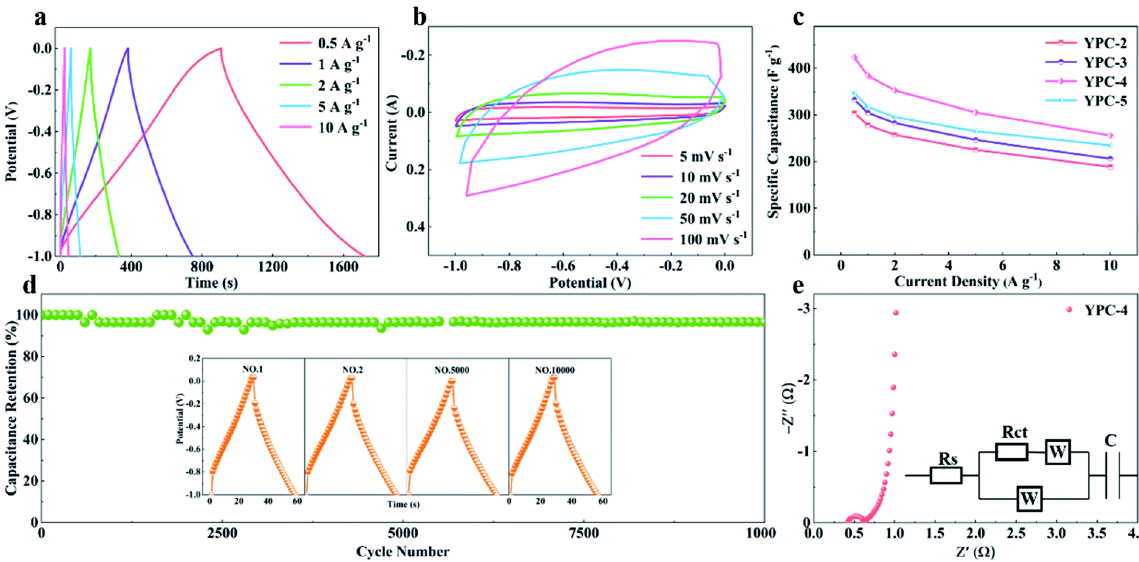
Figure 13. Electrochemical performance of YPC-4. ( a ) GCD profiles at different current densities; ( b ) CV curves at different scan rates; and ( c ) specific capacitance values of YPC-4 at different current densities. ( d ) Cycling performance of the YPC-4 electrode over 10,000 cycles at 10 A g − 1 ; the inset shows the GCD profiles at different cycles. ( e ) Nyquist plot of the YPC-4 electrode; the inset shows the corresponding equivalent circuit model. Adapted from reference [85]. This article is an open- (CC BY 3.0)